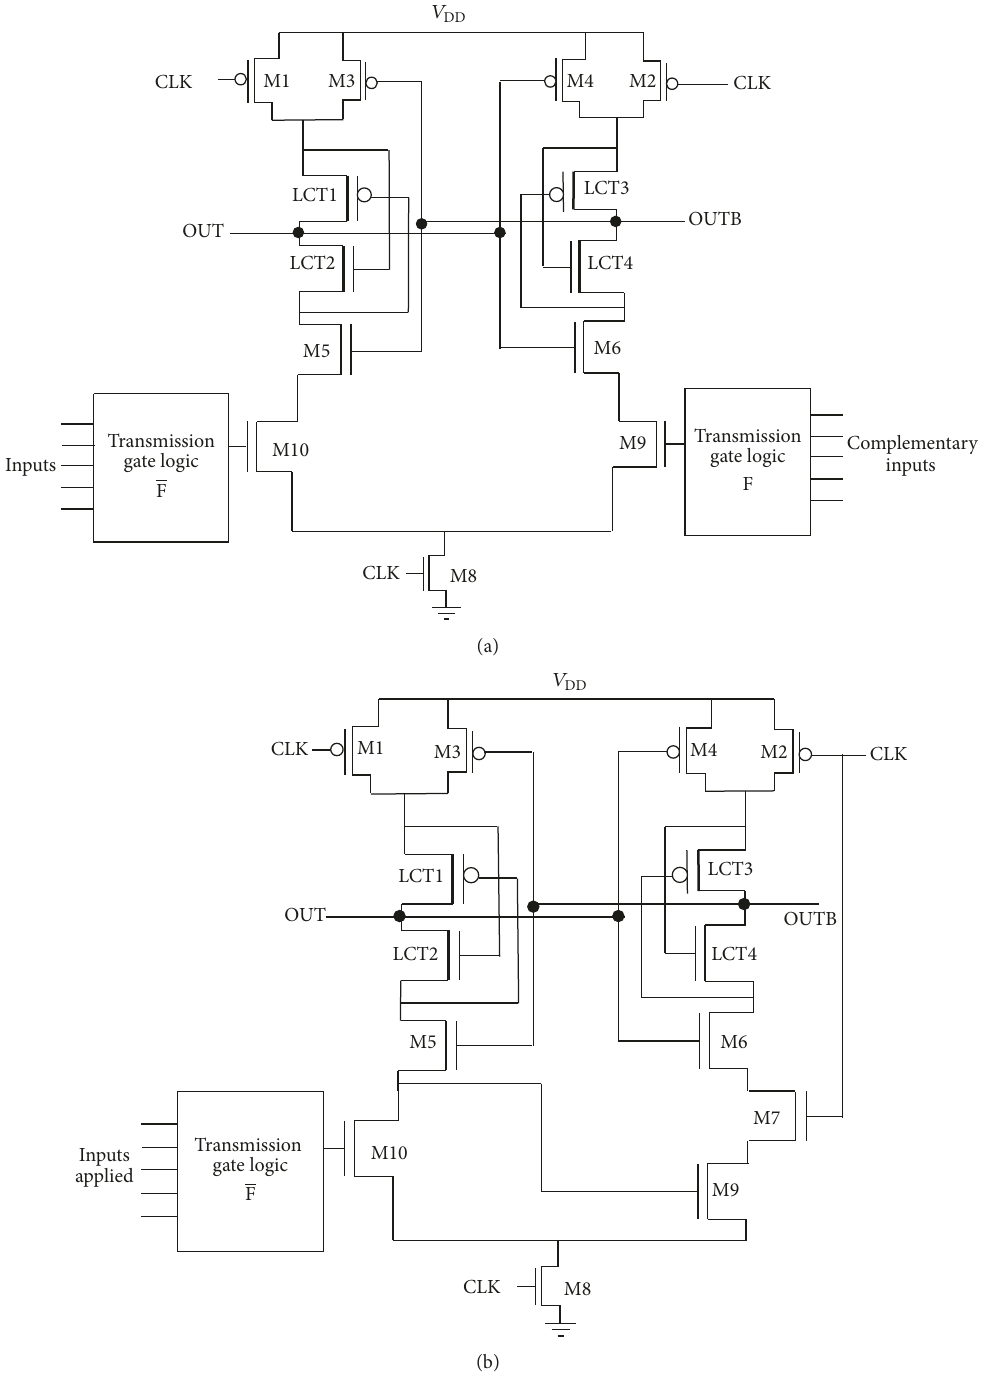
Figure 6: Proposed architecture-3 based (a) Dy-TG-DCVSL-LCT and (b) TG-EDCVSL-LCT circuits.